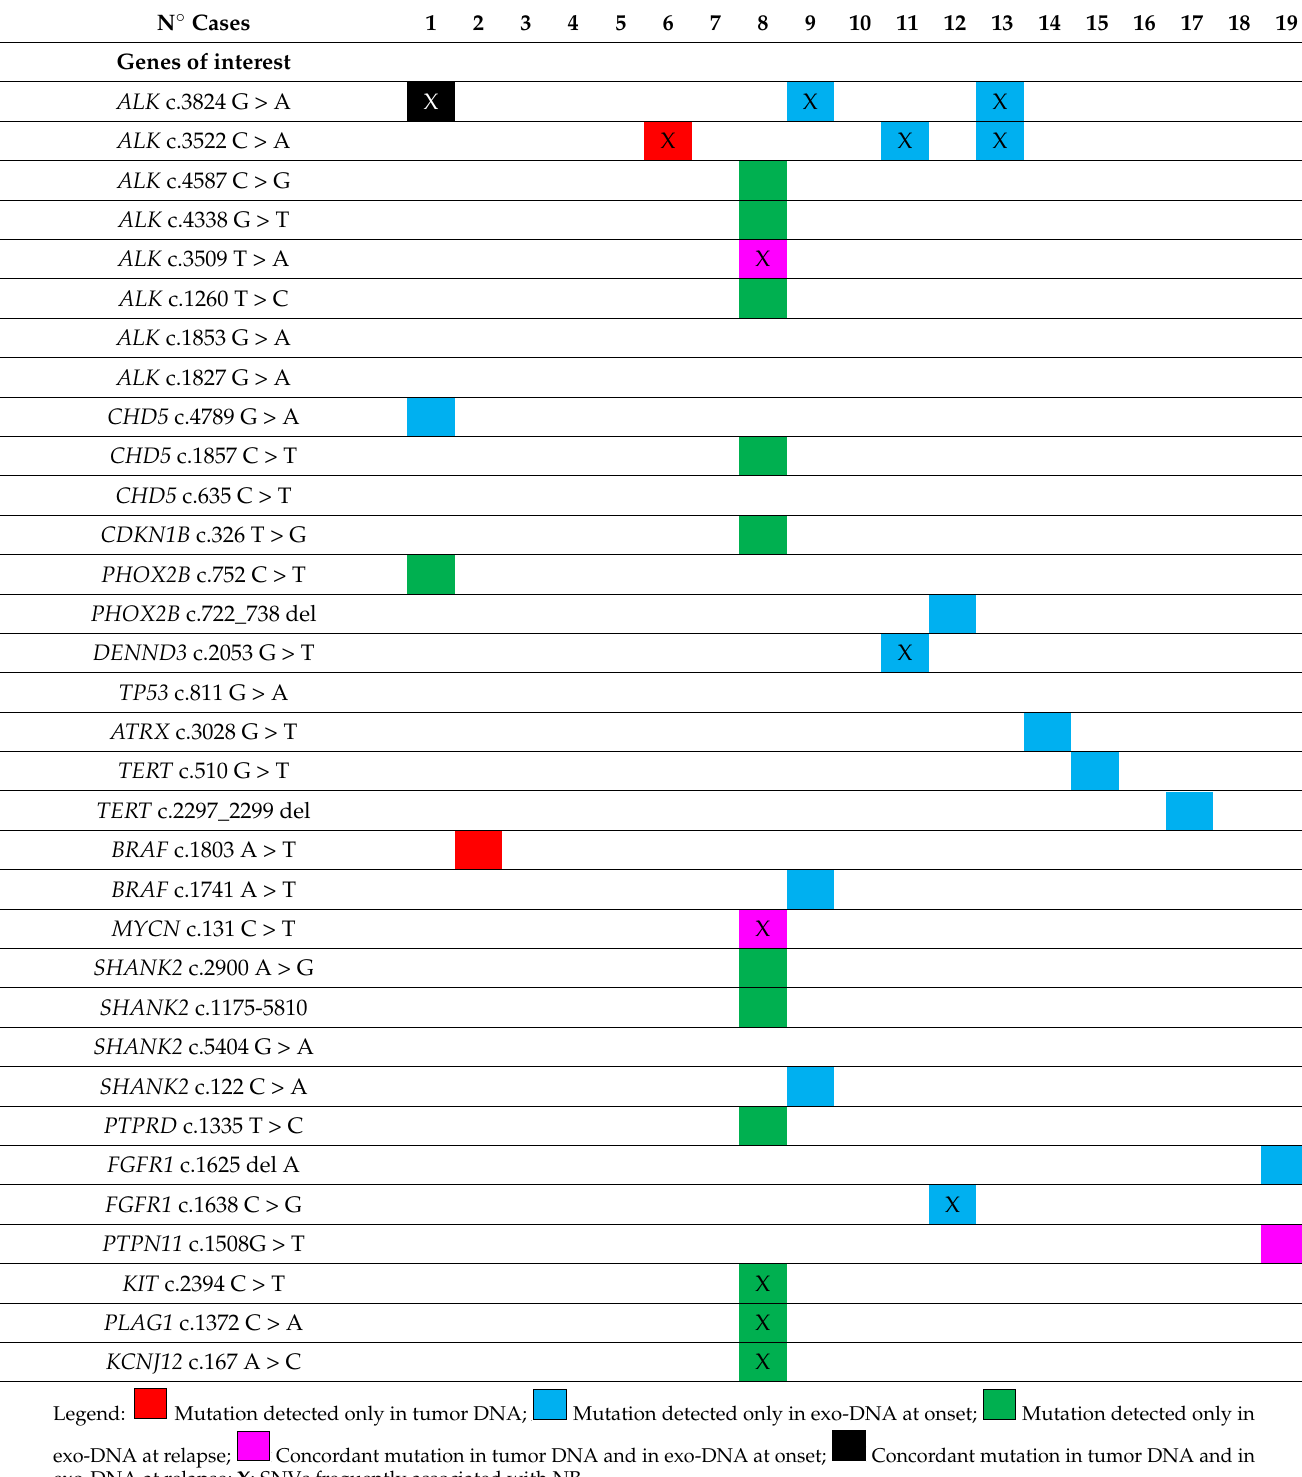
Table 3. Somatic SNVs identified in tumor DNA and in exo-DNA samples.